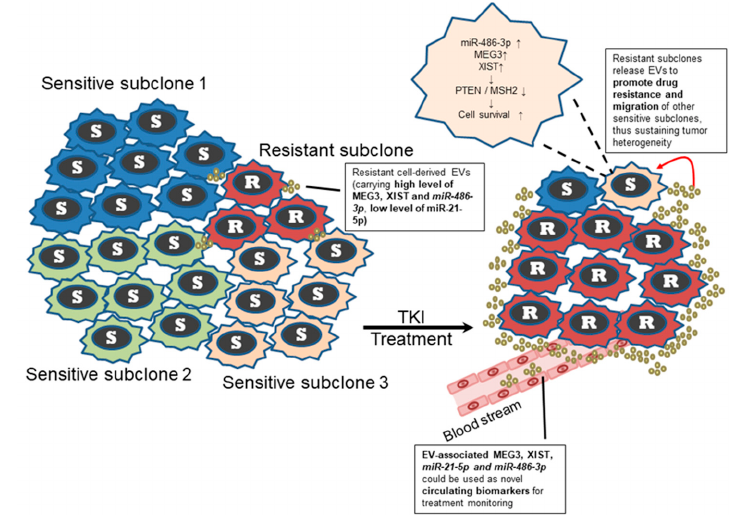
Figure 5. Hypothetical model for reinforcement of intratumoural heterogeneity via the transfer of EV-associated RNAs derived from resistant subclones of ALK -translocated lung adenocarcinoma. EV transfer from ALK-TKI resistant subclones to sensitive subclones may promote drug resistance of the sensitive subclones. Low miR-21-5p and high miR-486-3p , lncRNAs MEG3 and XIST in the EVs released by the resistant subclones could inhibit the expression of tumour suppressors PTEN and MSH2 by the neighboring recipient subclones and enhance their survival. Level of serum EV-associated miRNAs miR-21-5p , miR-486-3p , lncRNAs MEG3 and XIST appeared to correlate with disease and treatment course in patients with ALK -translocated lung adenocarcinoma undergoing ALK-TKI treatment.